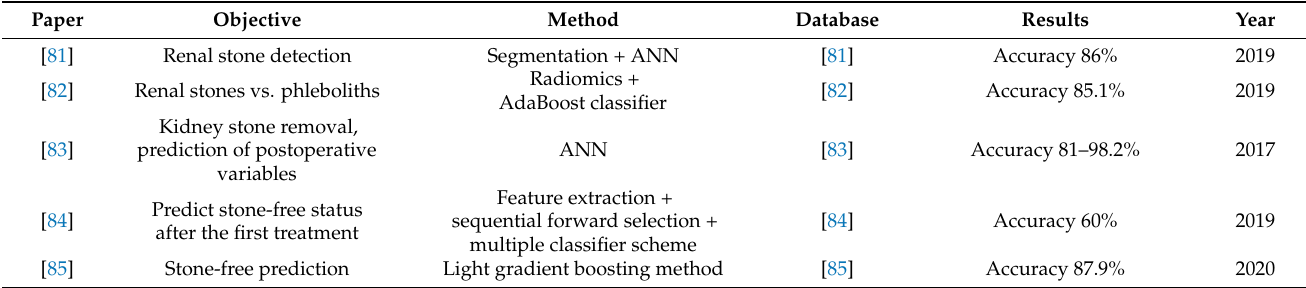
Table 4. Kidney stone research.